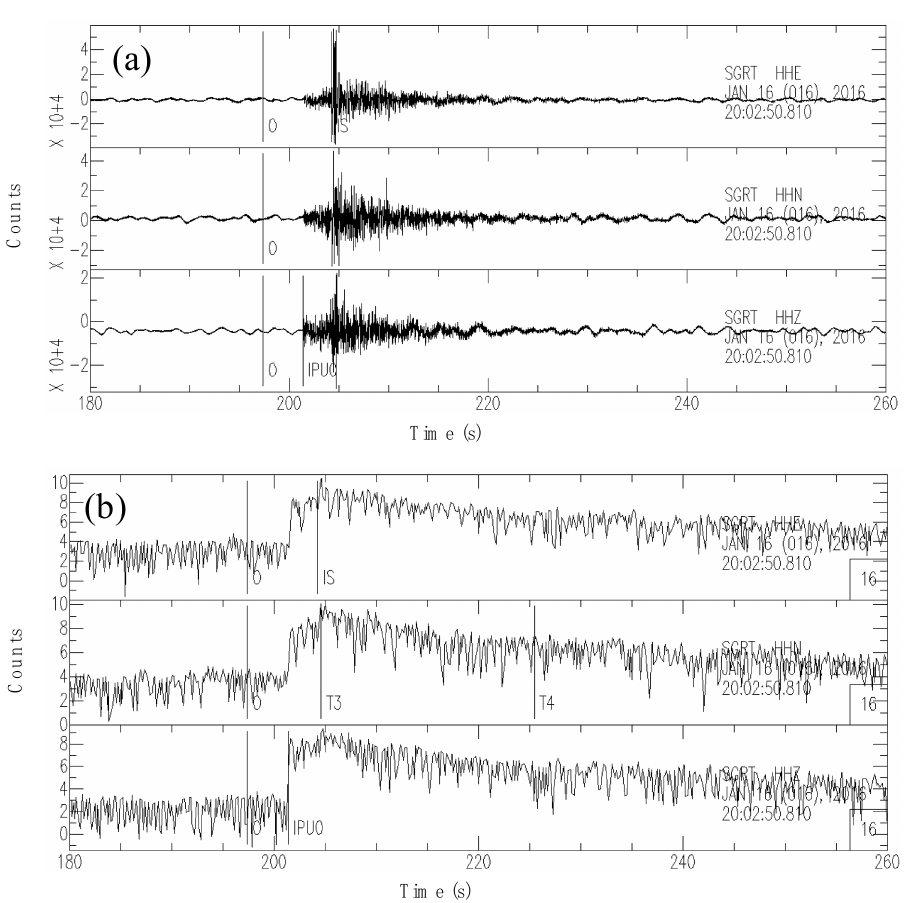
Figure 3. ( a ) Original three-component record (count/s) at station SGRT (IV network) with origin O, P-wave and S-wave arrival markers. ( b ) Energy envelope (count/s) filtered around f c = 6 Hz, with T 3 and T 4 markers (see the text for explanation).